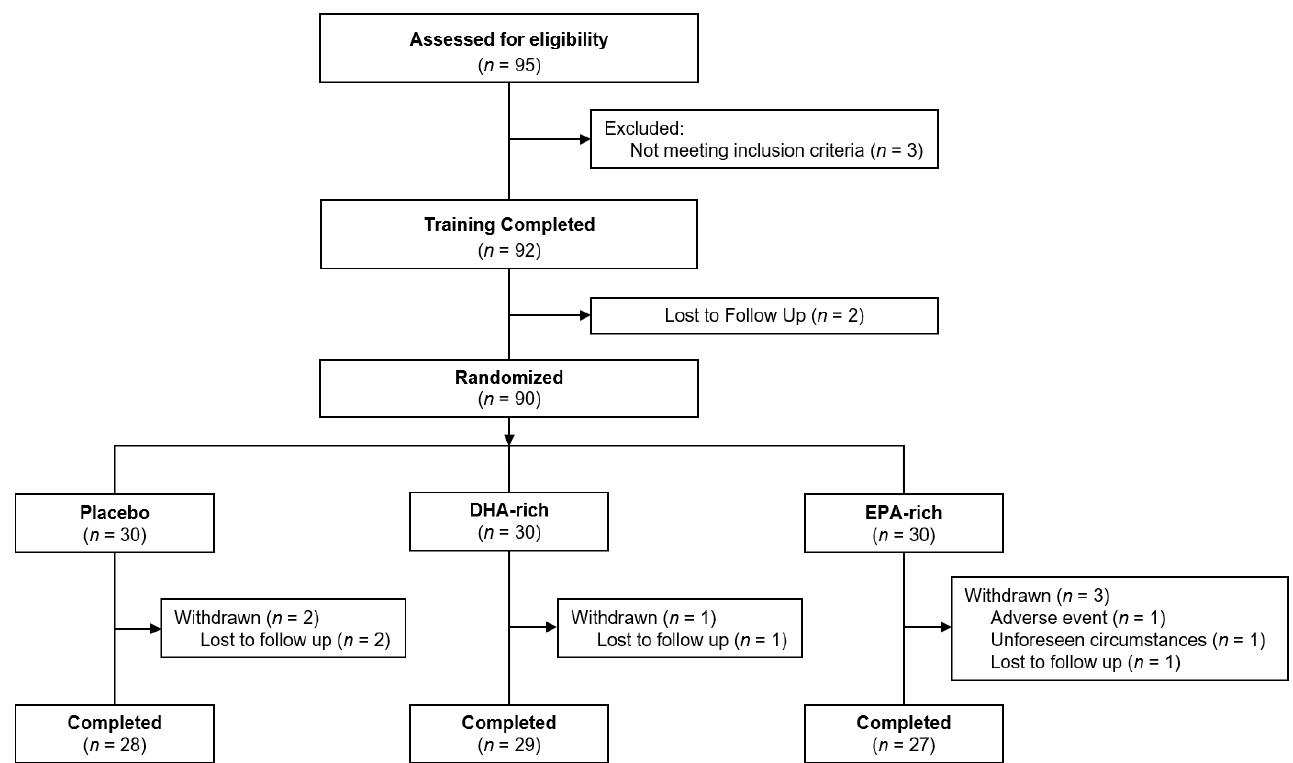
Figure 1. Participant disposition through the trial. Figure depicts the disposition of participants throughout the study, culminating in n = 84 of the 90 who were randomized. Table 1. Demographic information and baseline characteristics for the 84 participants who com- pleted all aspects of the study. Means ± SD are given where appropriate. Baseline differences were assessed using separate one-way ANOVAs or chi-square tests; resulting p values from these anal- yses are presented.